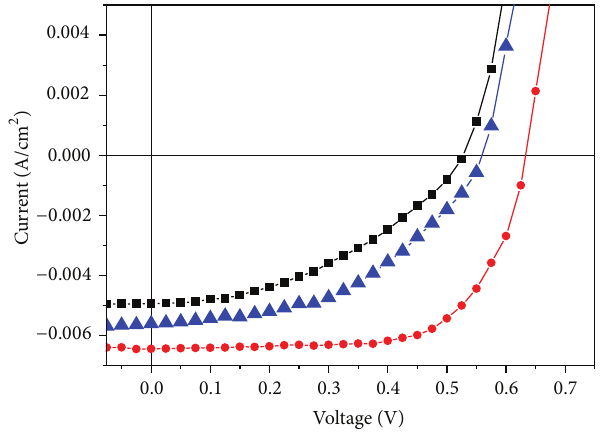
Figure 4: I ( V ) characteristics of (i) ITO/PEDOT:PSS/P3HT 0.3 : CuPc 0.3 :C60 0.4 /BCP/Al heat-treated ( ∙ ), (ii) ITO/PEDOT:PSS/ P3HT 0.3 :CuPc 0.3 :C60 0.4 /BCP/Al ( 󳵳 ), and (iii) ITO/PEDOT:PSS/ CuPc 0.5 :C60 0.5 /BCP/Al ( ◼ ).